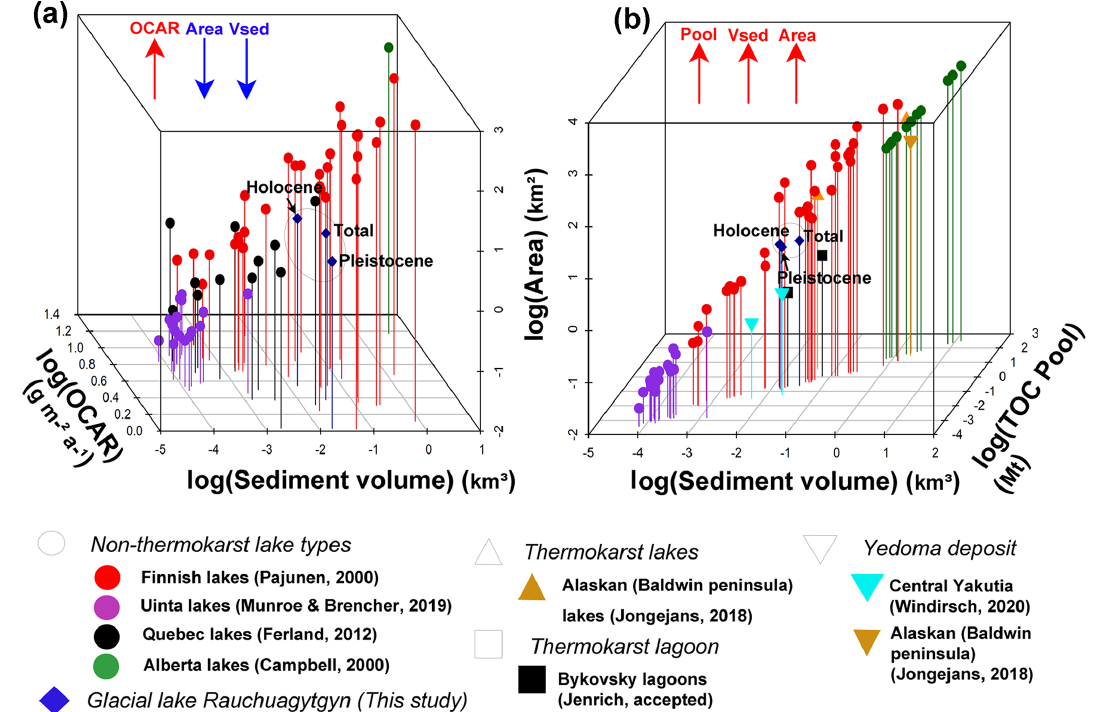
Figure 9. (a) Three-dimensional log scatter plot of organic carbon accumulation rate (OCAR) vs. lake sediment volumes and surface areas. The average carbon accumulation rate for the Holocene at Lake Rauchuagytgyn closely resembles that of Holocene age Finnish and Quebec lakes and generally lies on a trajectory of increasing OCAR with decreasing sediment volume and area. (b) Three-dimensional log scatter plot of carbon pool vs. sediment volume and area. The Rauchuagytgyn data points are highlighted with ellipses in both plots. Rauchuagytgyn displays similar carbon pools to Finnish lakes, Bykovsky thermokarst lagoons and central Yakutian yedoma deposits. Rauchuagytgyn sed- iments possess, however, significantly lower carbon pools relative to volume and area than Alaskan (Baldwin Peninsula) thermokarst lake and yedoma deposits and Alberta